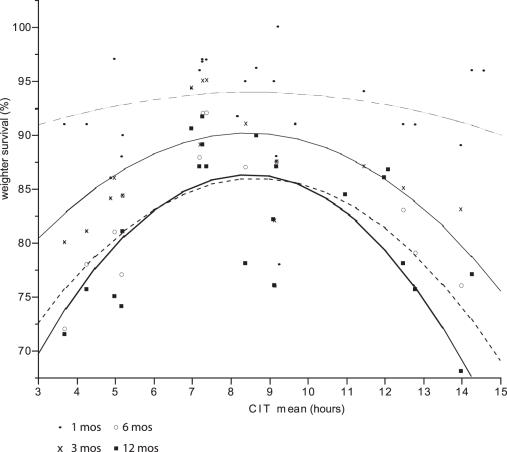
Patient Survival at 1, 3, 6 and 12 months versus mean CIT.